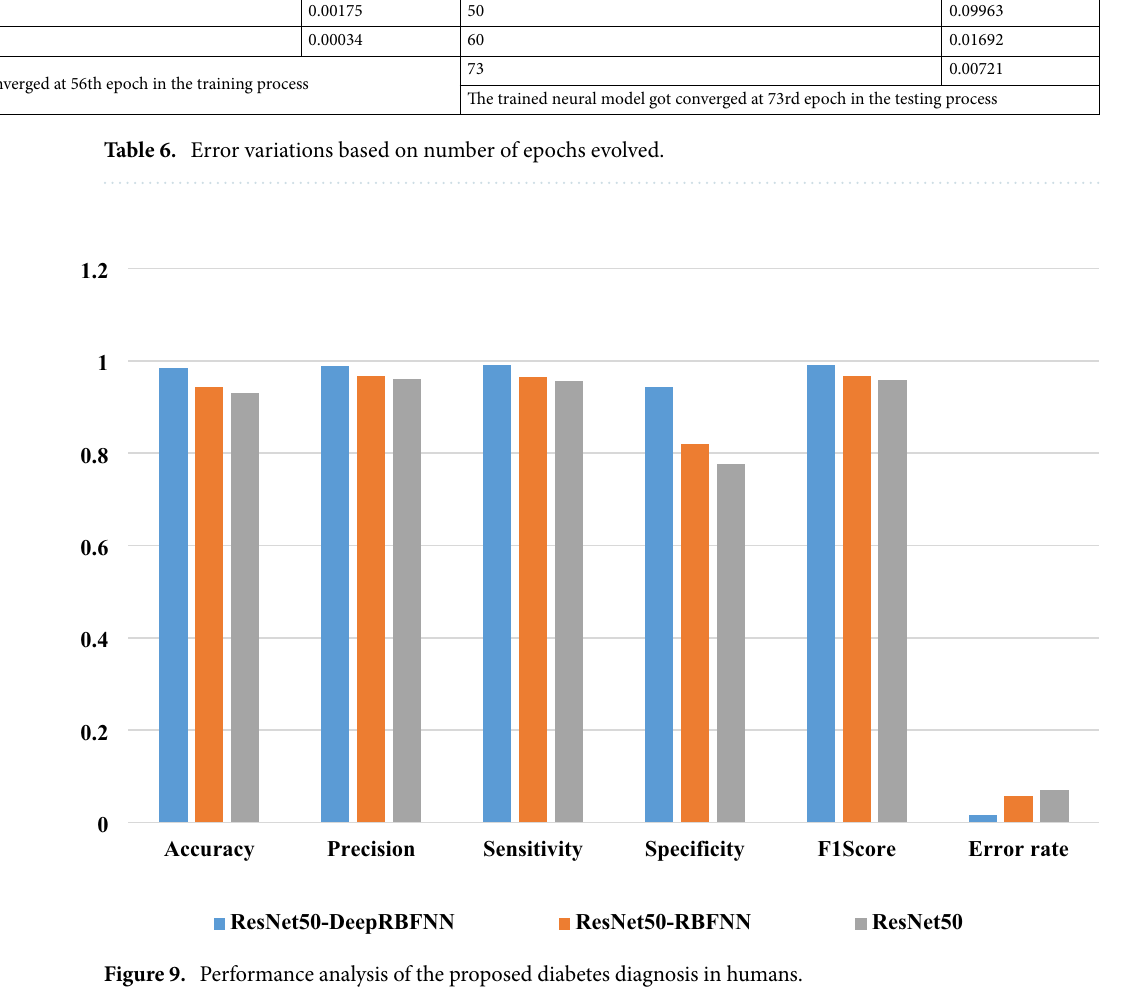
Figure 9. Performance analysis of the proposed diabetes diagnosis in